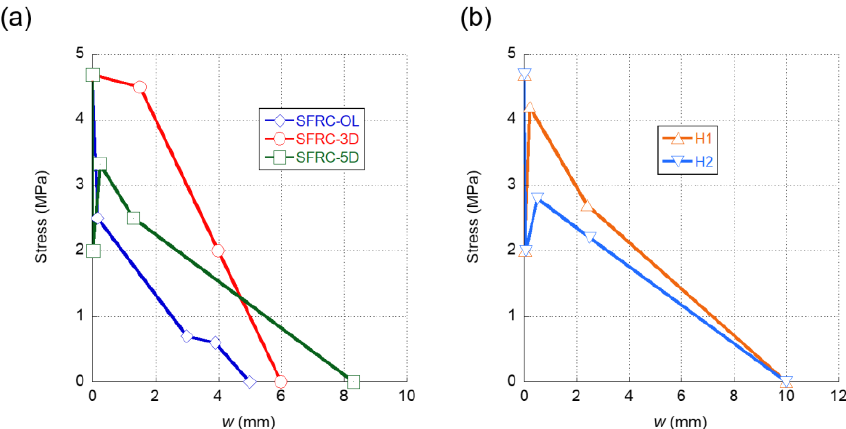
Figure 9. ( a ) Softening functions obtained in the inverse analysis of SFRC-OL, SFRC-3D, and SFRC-5D. ( b ) Softening functions obtained in the inverse analysis of H1 and H2.